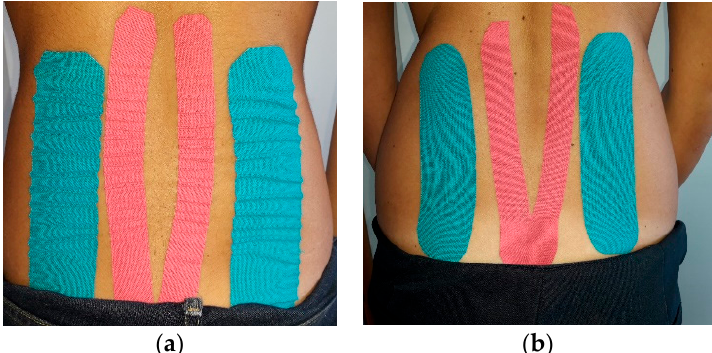
Figure 1. Examples of KT on spine: ( a ) taping with no tension for decompressive application; ( b ) taping with tension for postural application.